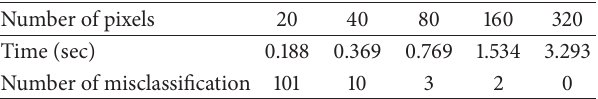
Table1:Executiontimeofclassificationandnumberofmisclassified samples for 200,000 test